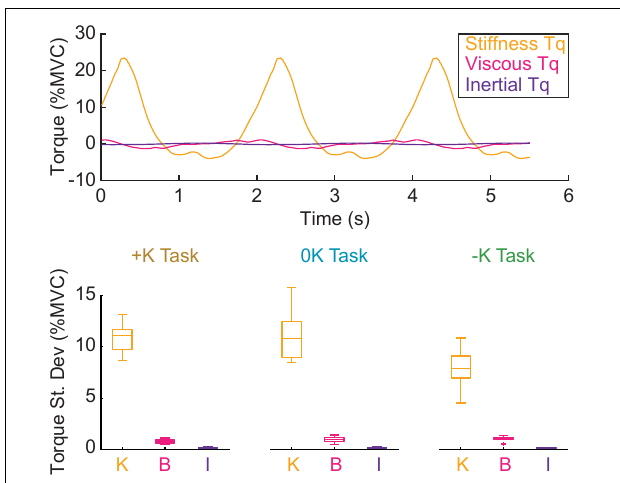
FIGURE 6 | Stiffness was the dominant contributor to the impedance torque. (A) The torque due to, stiffness (orange) viscosity (magenta) and inertia (purple) for a single task in a representative subject. (B) The torque due to stiffness was approximately an order of magnitude greater than the torque due to viscosity and two orders of magnitude greater than the torque due to inertia for all tasks.